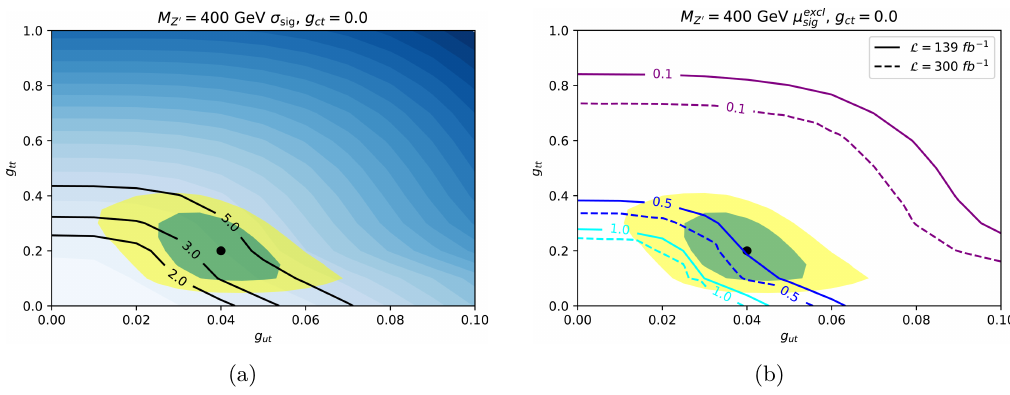
Figure 10 . Left: expected significance using global bins for 139 fb − 1 . Right: expected exclusion limits on the ( tZ 0 + ttZ 0 ) signal strength µ . Solid (dashed) lines are limits for 139 fb − 1 (300 fb − 1